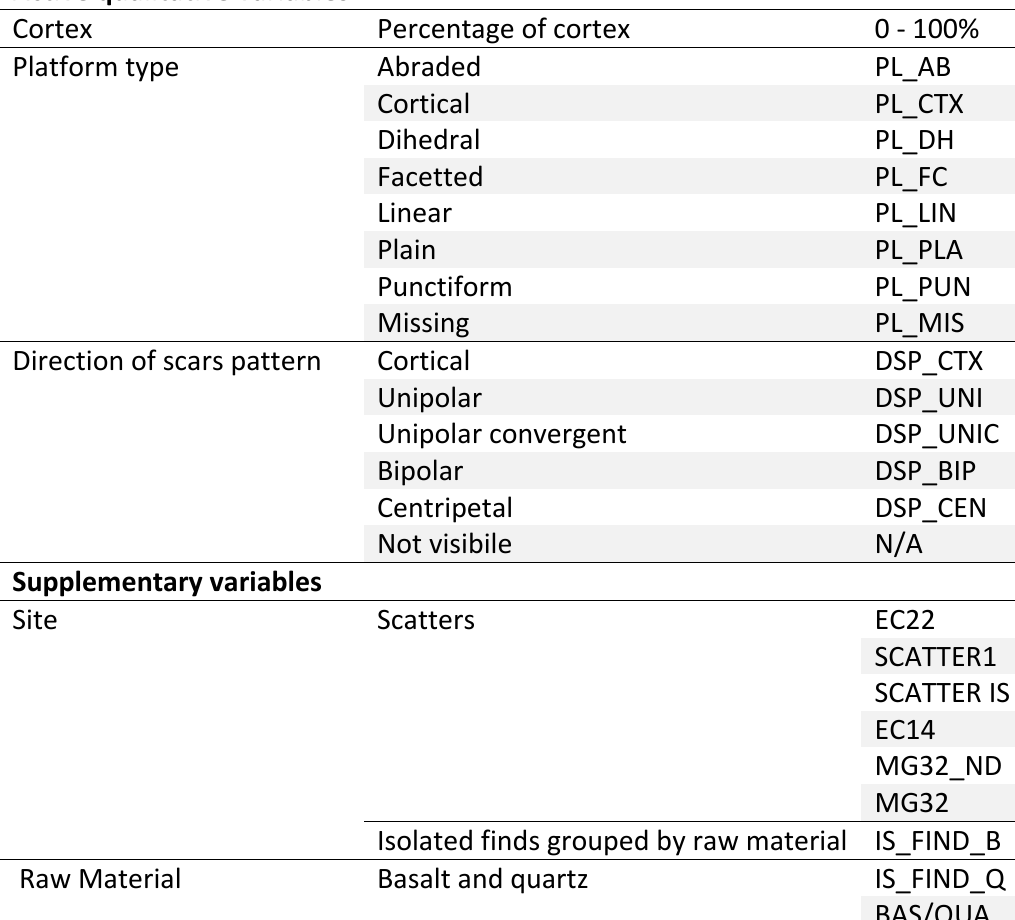
Table 4. List of categorical variables used to perform the Correspondence analysis on